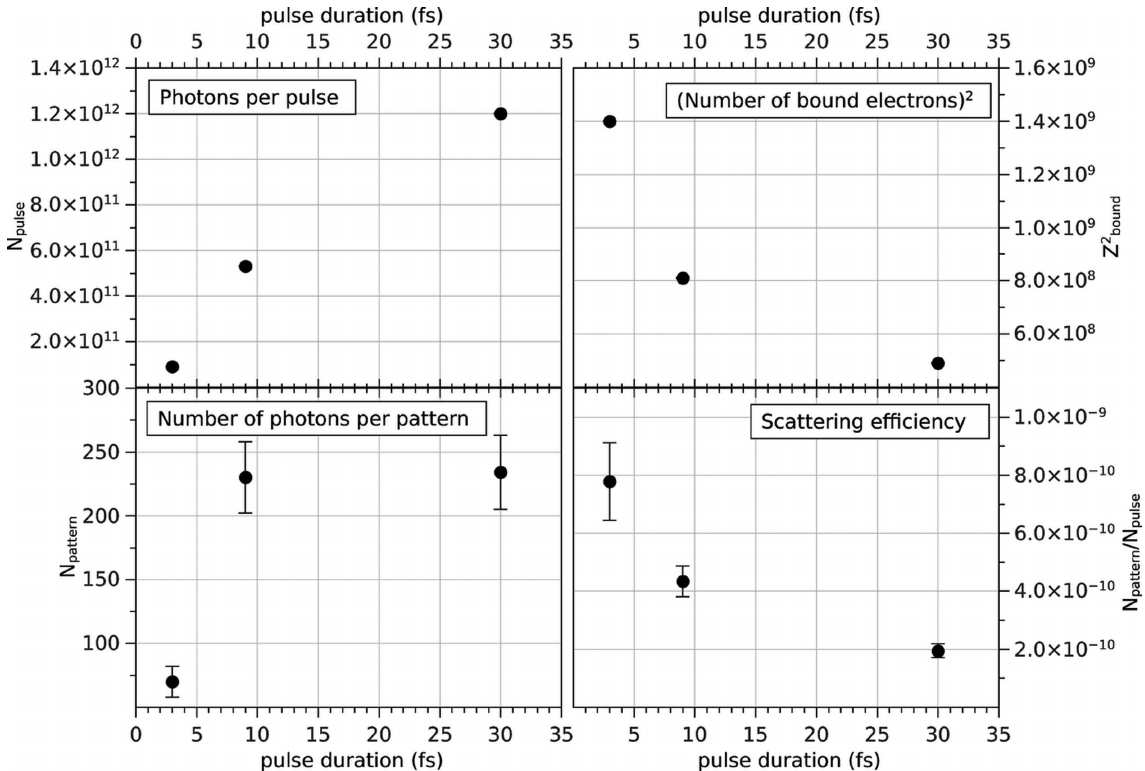
Figure 2 (Top left) The number of photons per pulse incident on the sample ( N ph,pulse ) as a function of pulse duration. (Bottom left) The number of detected photons per diffraction pattern ( N ph,det ). (Top right) The square of the average number of bound electrons in the sample molecule ( N 2 middle of the pulse. (Bottom right) The scattering efficiency N ph,det / N ph,pulse . The decrease in N e,bound as a consequence of ionization processes results in a reduced scattering efficiency with increasing pulse duration. Nevertheless, the total number of detected photons increases, since the longer pulses contain more